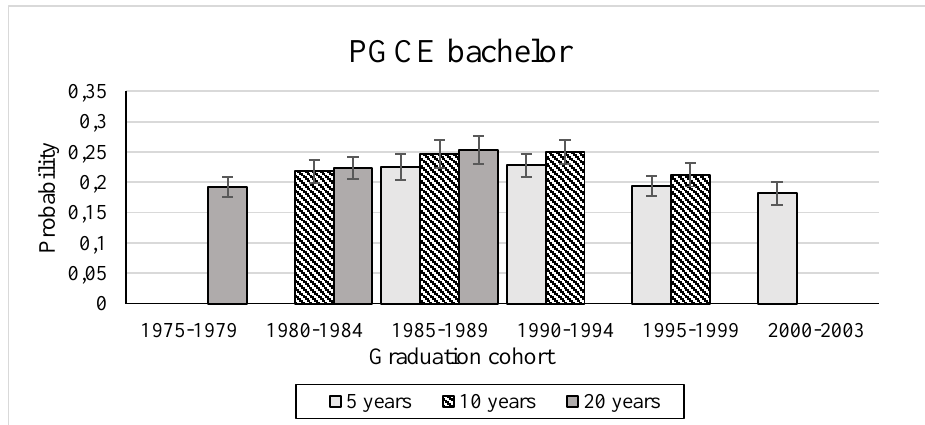
Figure 1. Predicted probability that bachelor’s graduates with postgraduate teacher education (PGCE) are not employed in the school sector, by graduation cohort at 5, 10, and 20 years after graduation. 95% CI error